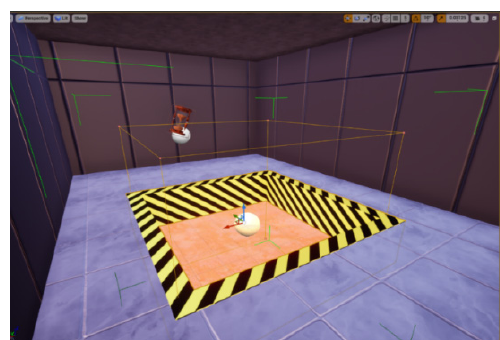
Figure 6. Example of the pitfall trap solution.